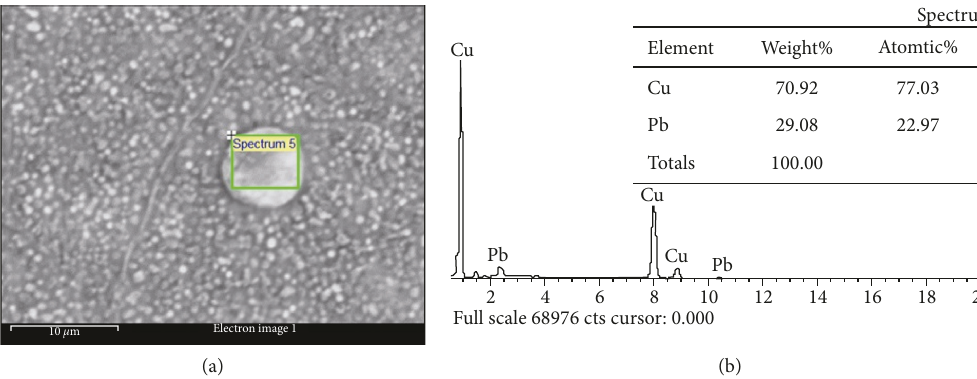
Figure 4: Energy spectrum of Cu-40 wt.% Pb hypermonotectic alloy under low undercooling.